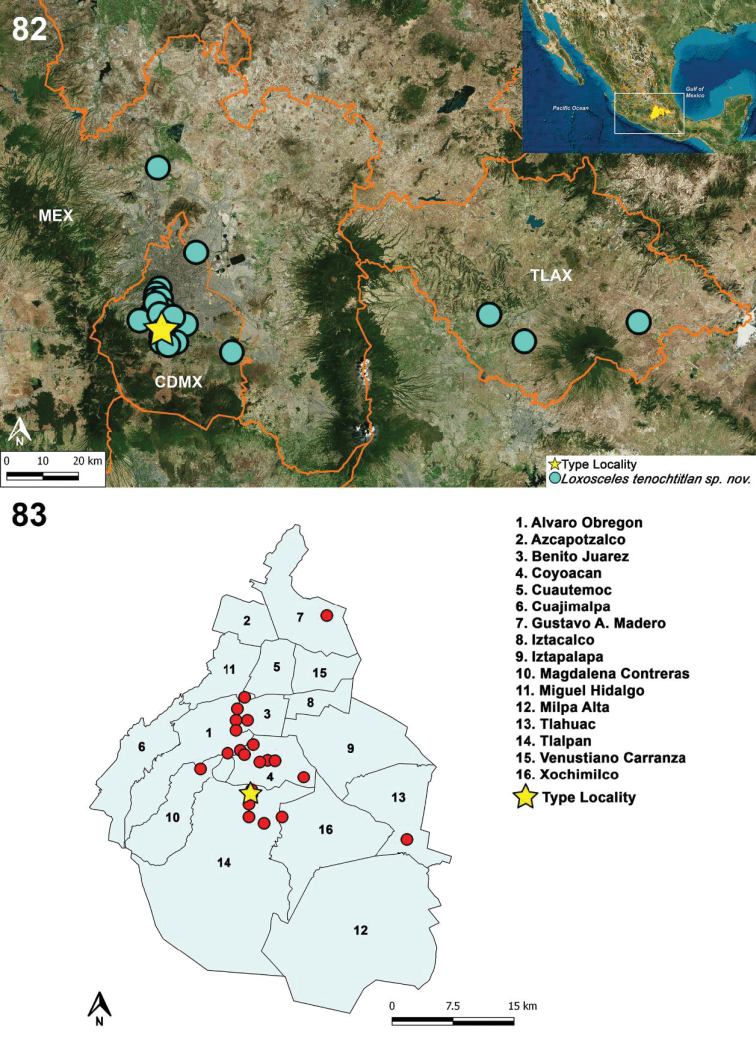
82 Distribution records of Loxosceles
tenochtitlan sp. nov. from Mexico City (CDMX), Estado de Mexico (MEX), and Tlaxcala (TLAX) 83 known records of L.
tenochtitlan sp. nov. from Mexico City, including the type locality (star).